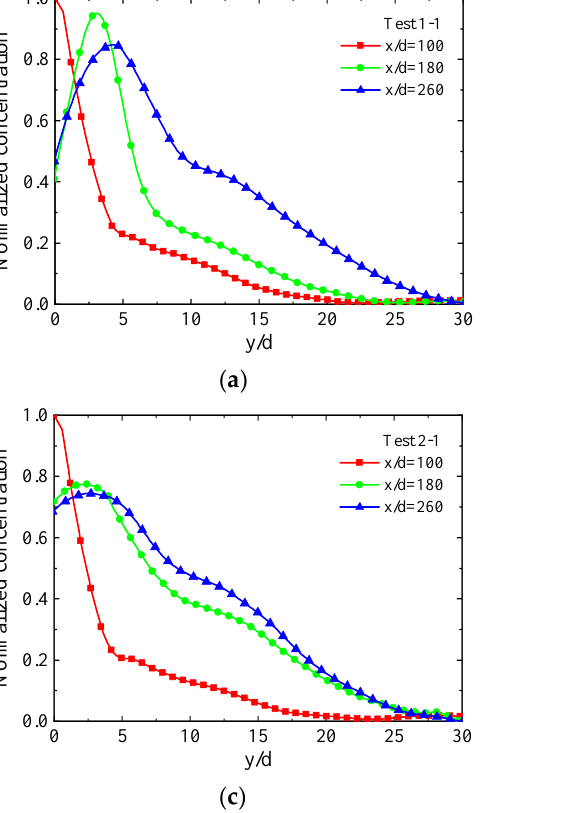
Figure 15. Concentration curves of EHF jet along the flow direction under Ma 2.0. ( a ) Ma = 2.0, P j = 2.8 MPa, T j = 705 K. ( b ) Ma = 2.0, P j = 2.8 MPa, T j = 730 K. ( c ) Ma = 2.0, P j = 4.2 MPa, T j = 707 K. ( d ) Ma = 2.0, P j = 4.1 MPa, T j = 735 K.